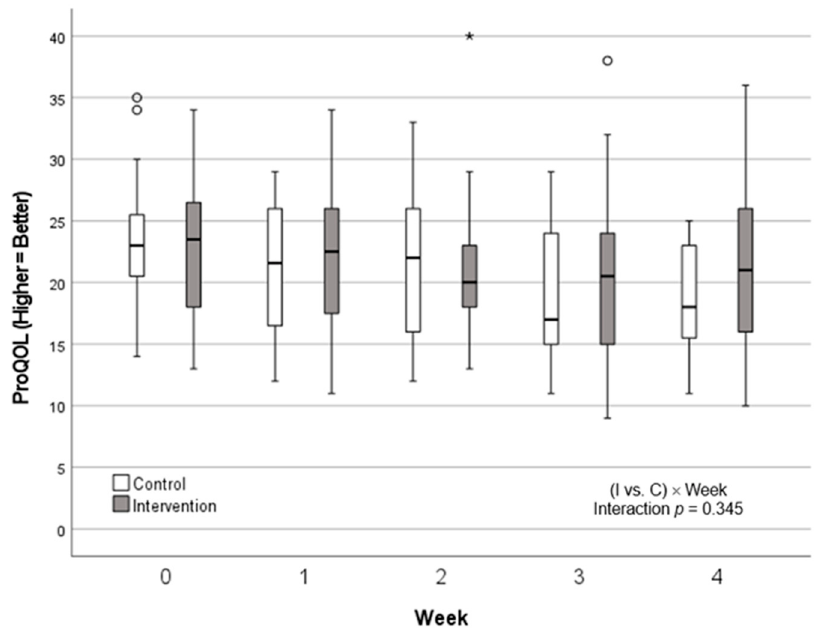
Figure 3. Professional quality of life (PROQOL) scores over time by group. * p < 0.05.